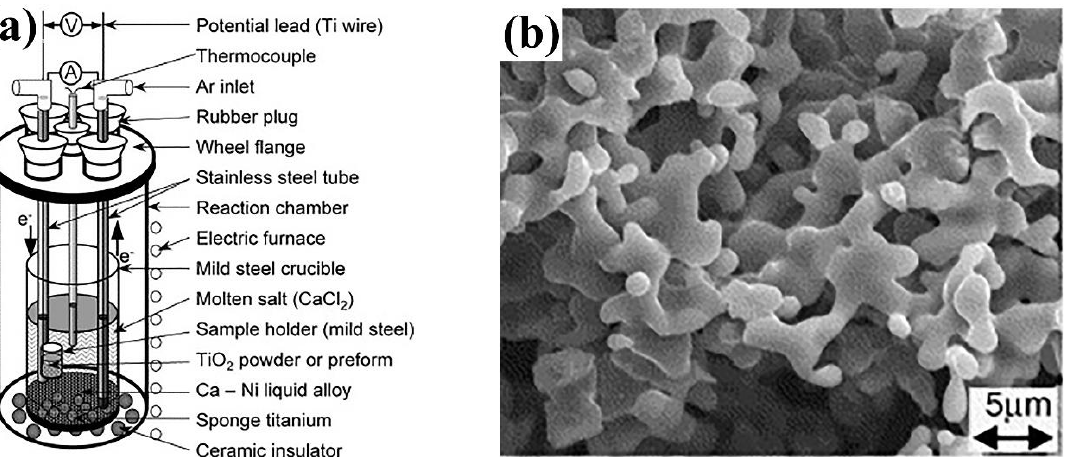
Figure 8. ( a ) Schematic illustration of experimental apparatus of the EMR process; ( b ) SEM image of titanium powder produced by the EMR process [72] (Adapted from [72], with permission from Elsevier, 2005).